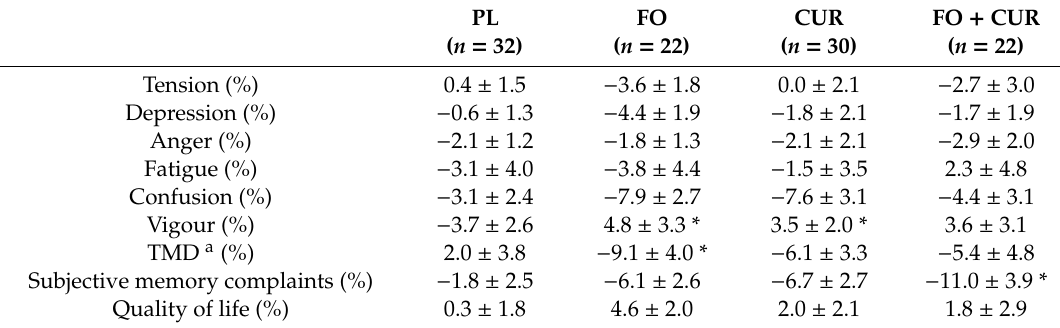
Table 4. Subanalysis of treatment changes in measures of mental wellbeing and quality of life in APOE4 non-carriers ( n =